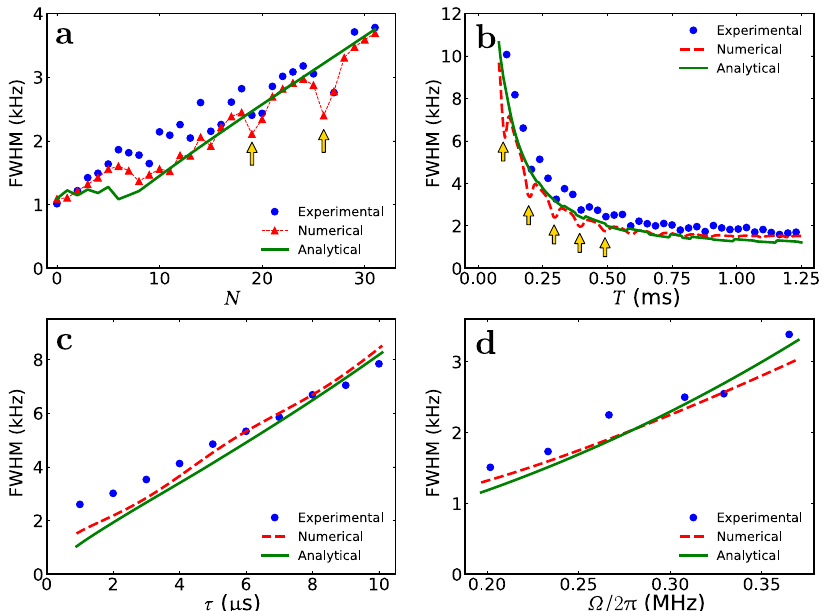
Fig. 4 FWHM aspects of multi-pulse CPT-Ramsey interferometry. a The FWHM vs. the pulse number N with Ω = 2 π × 0.28 MHz, T = 0.5 ms, and τ = 2 μ s. b The FWHM vs. the integration time T with Ω = 2 π × 0.28 MHz, N = 15, and τ = 2 μ s. c The FWHM vs. the pulse length τ with Ω = 2 π × 0.28 MHz, N = 15, and Δ T = 0.031 ms. d The FWHM vs. the average Rabi frequency Ω with τ = 2 μ s, N = 15, and Δ T = 0.031 ms. The bias magnetic fi eld is chosen as B z = 0.116 G and the yellow arrows label the exotic dips due to magneto-sensitive transitions.